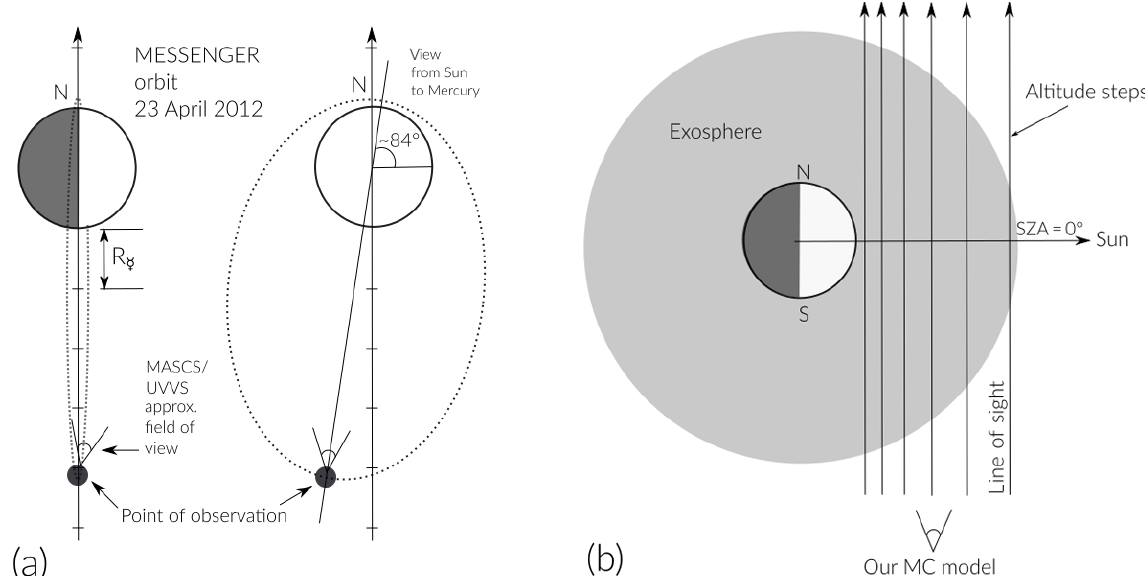
Figure 2. textbf(a) Representation to scale of MESSENGER’s orbit around Mercury during the time of observations (orbit parameters taken from https://www.nasa.gov). (b) Scheme of the line of sight used in the simulations (distance between altitude steps is not to scale). Solid black lines in (b) represent the altitude steps for integration of the column density when SZA = 0 ◦